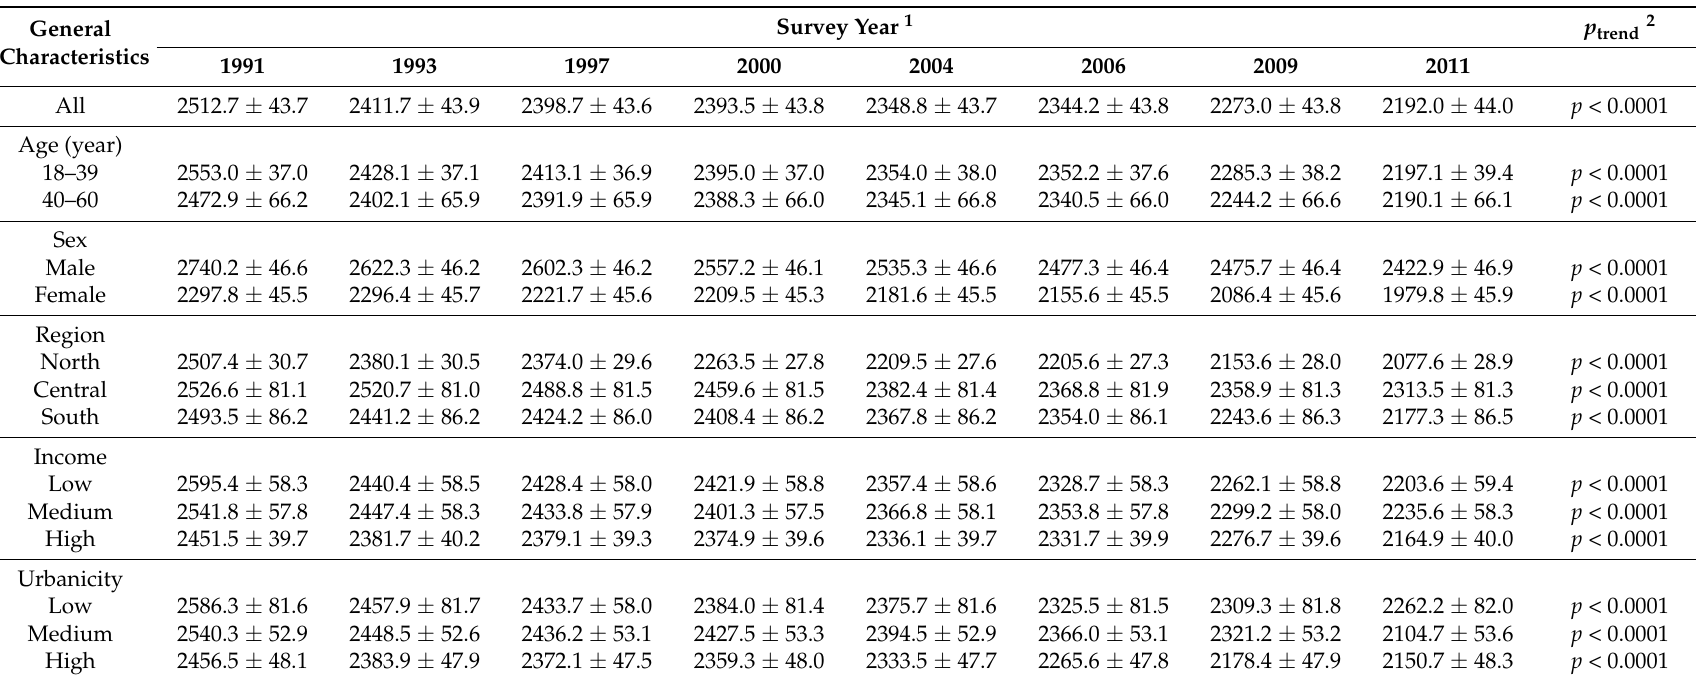
Table 2. Daily energy intake (Kcal), by age, sex, geographical region, income, and urbanicity, in Chinese rural adults from 1991 to